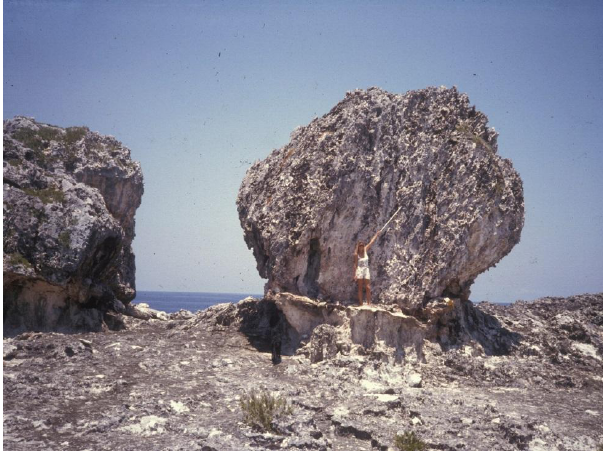
Figure 22. Megaboulders #1 (left) and #2 resting on MIS 5e eo- lianite at the crest of a 20m high ridge with person (1.7m) showing scale and orientation of bedding planes in the middle Pleistocene limestone. The greater age compared to underlying strata and dis- orientation of the primary bedding beyond natural in situ angles in- dicates that the boulders were